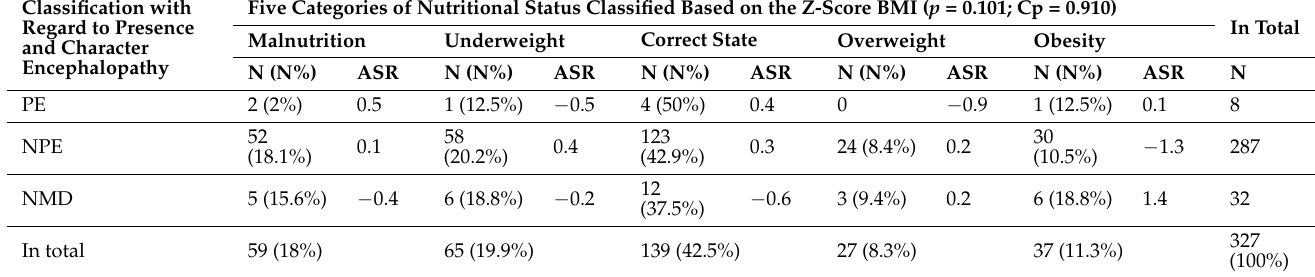
Table 9. Relationship between five categories of nutritional status classified based on the BMI z-score and classification with regard to presence and character encephalopathy.